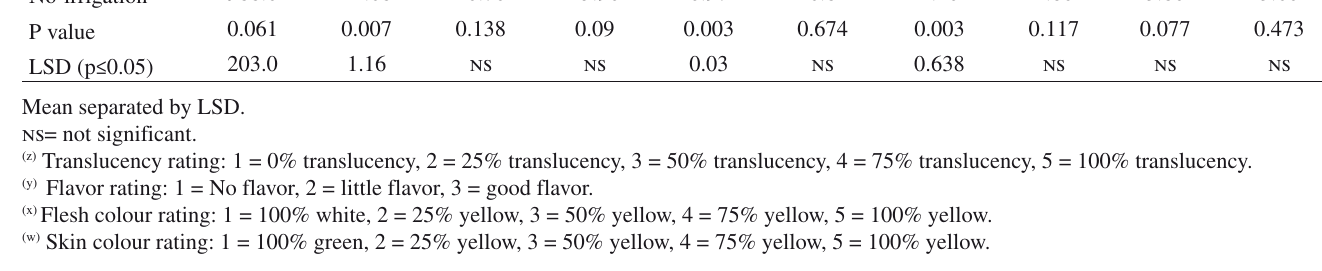
Mean separated by